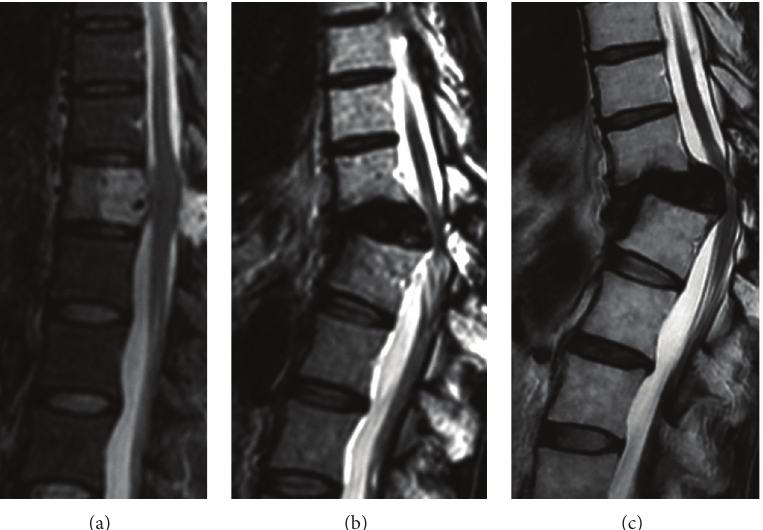
Figure 2: Time-course changes on T2-weighted MRI. (a) On the first examination at the urology department. (b) After one year. (c) After 3